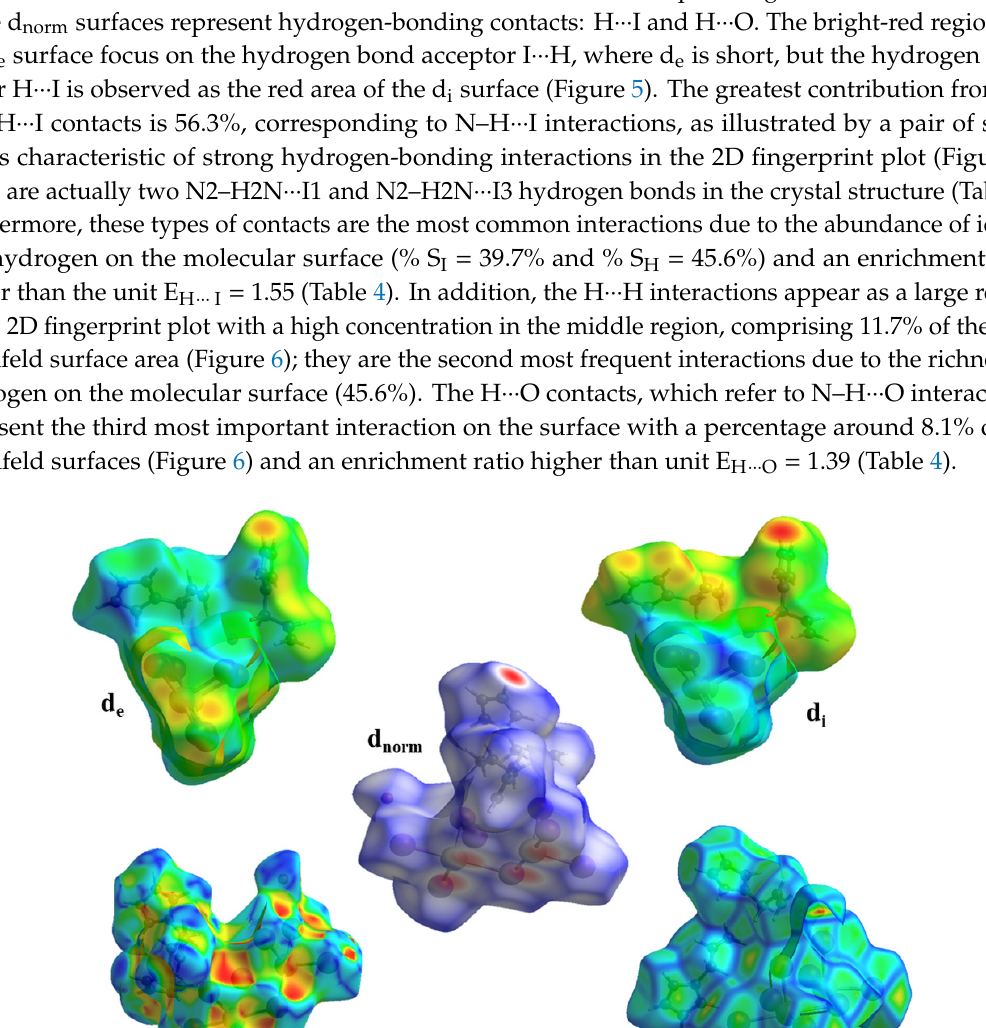
Figure 6. Fingerprint plots with d norm view of H ··· I, H ··· H, and H ··· O contacts in Bi 4 I 16 ·4(C 6 H 9 N 2 )·2(H 2 O).